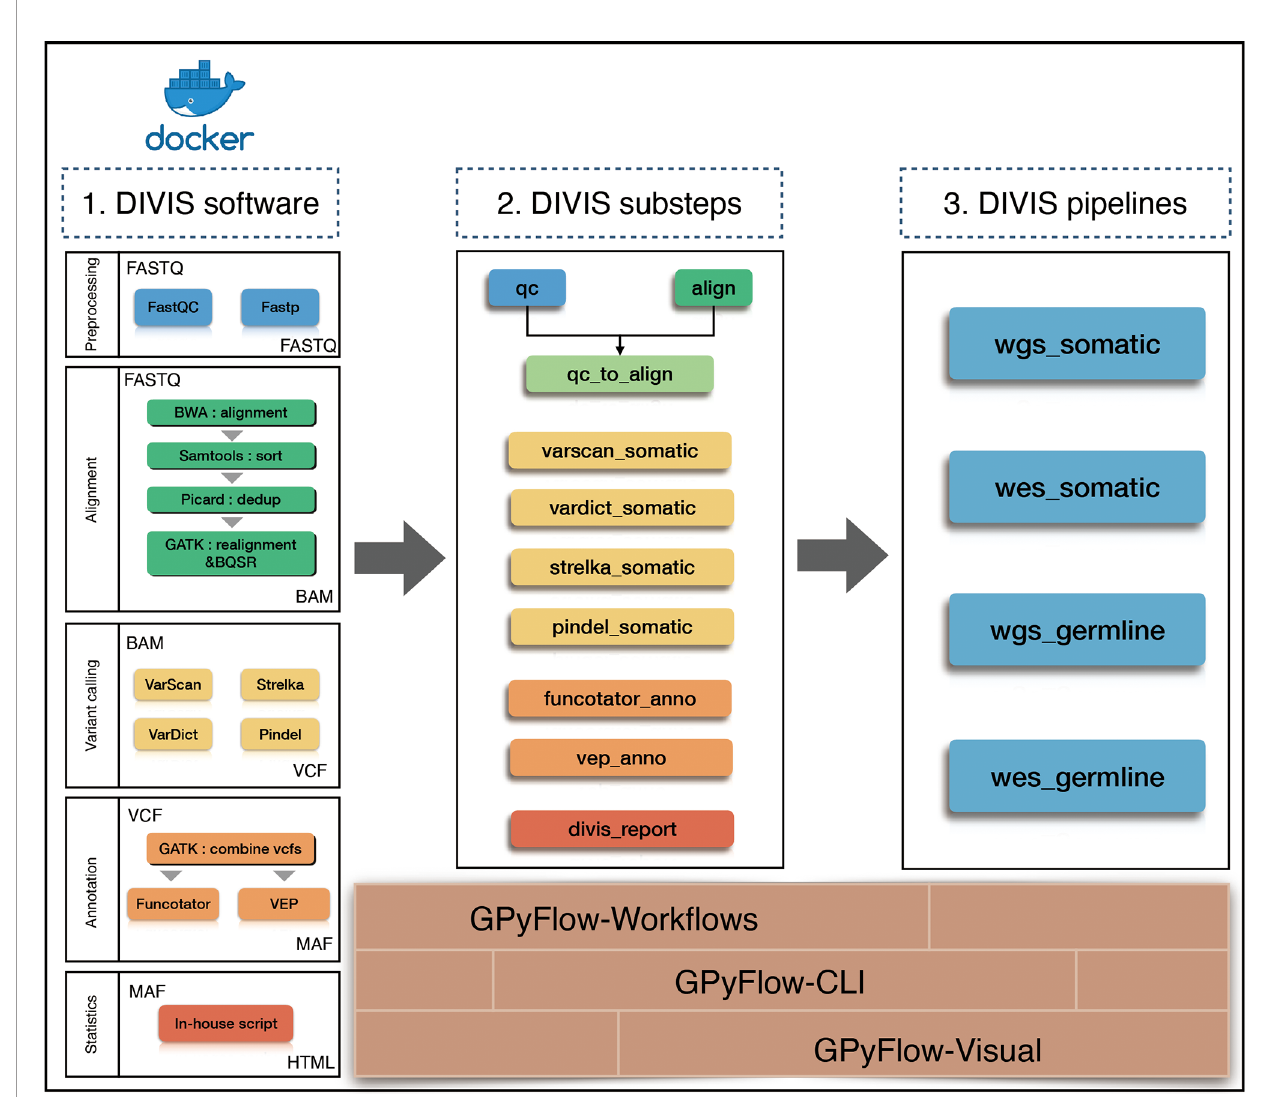
FIGURE 1 | Flowchart of DIVIS pipeline. All steps are managed by GPyFlow and DIVIS runs in two modes: compiled installer and